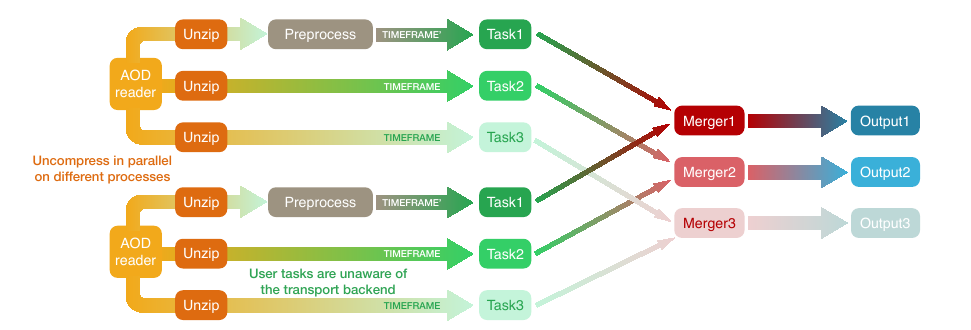
Figure 2. Example of an ALICE O 2 analysis workflow topology defined through the Data Processing